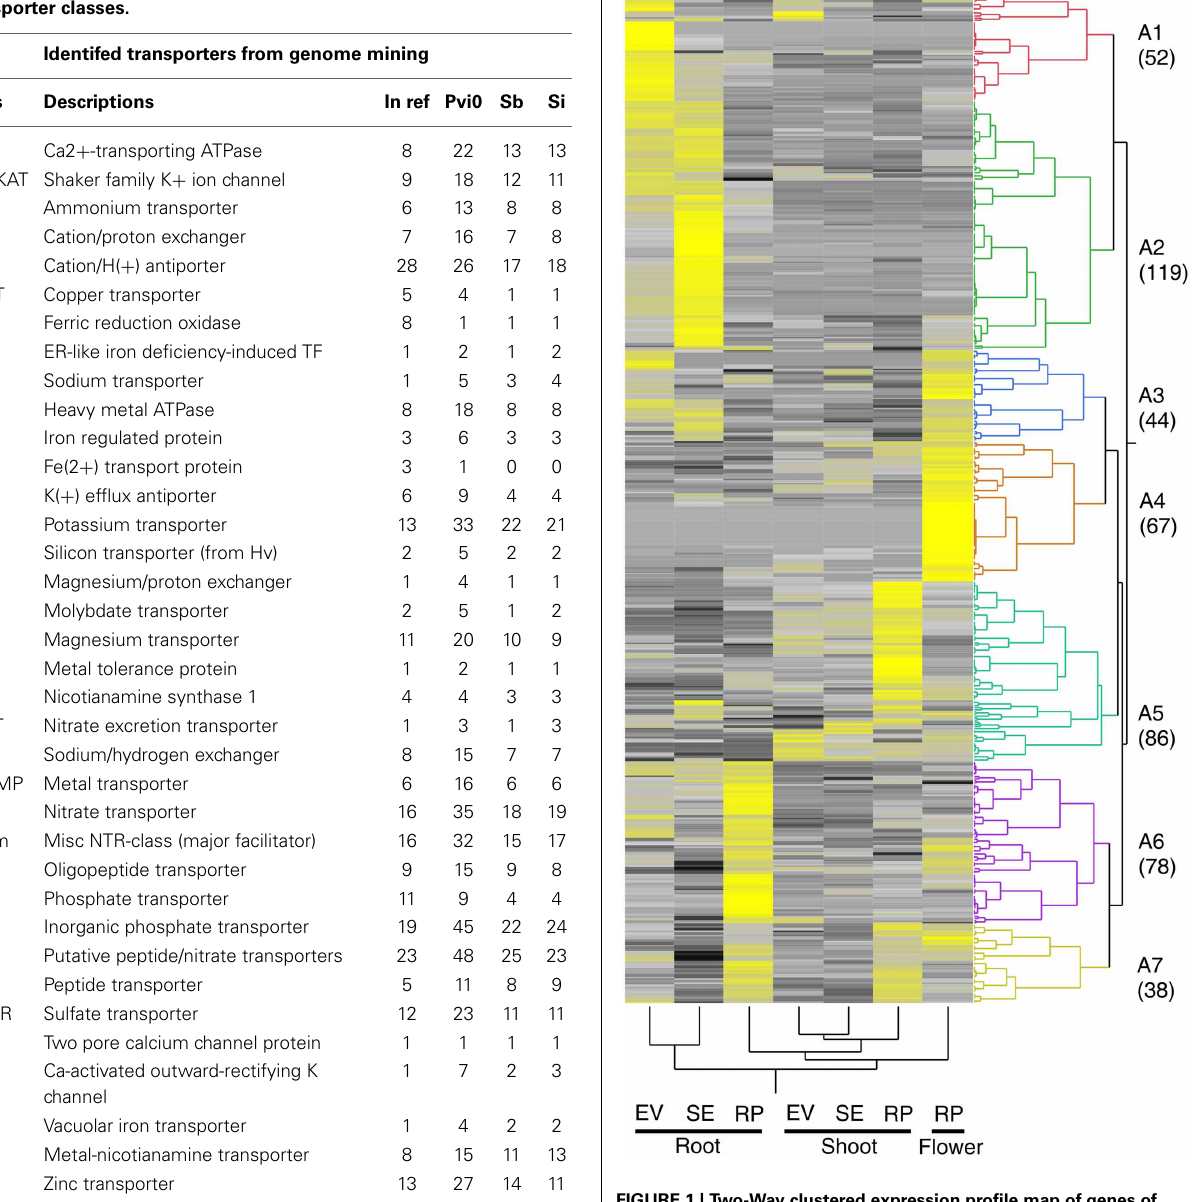
Table 1 | Bioinformatic analysis of switchgrass genome for mineral transporter classes.